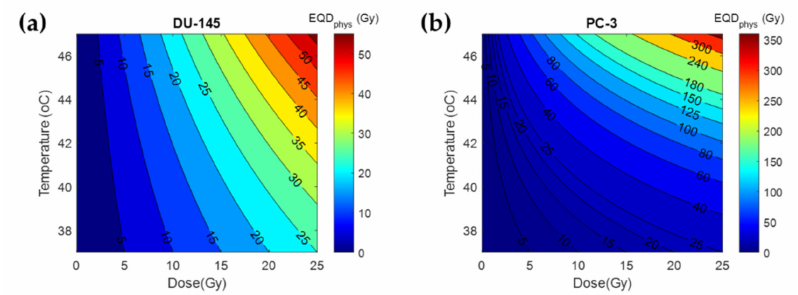
Figure 5. Isodose curves for the EQD phys resulting from different combinations of physical dose and temperature for 1 h: ( a ) EQD phys assuming DU-145 data; ( b ) EQD phys assuming PC-3